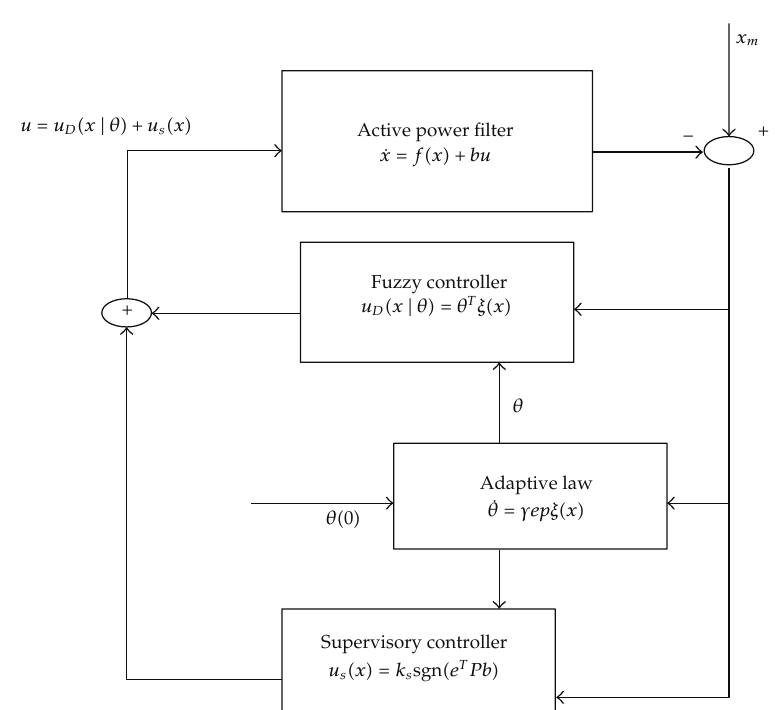
Figure 2: Adaptive fuzzy control block for